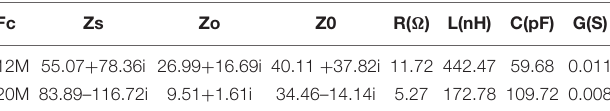
TABLE 2 | The input impedance of the open circuit and short circuit. Fc Zs Zo Z0